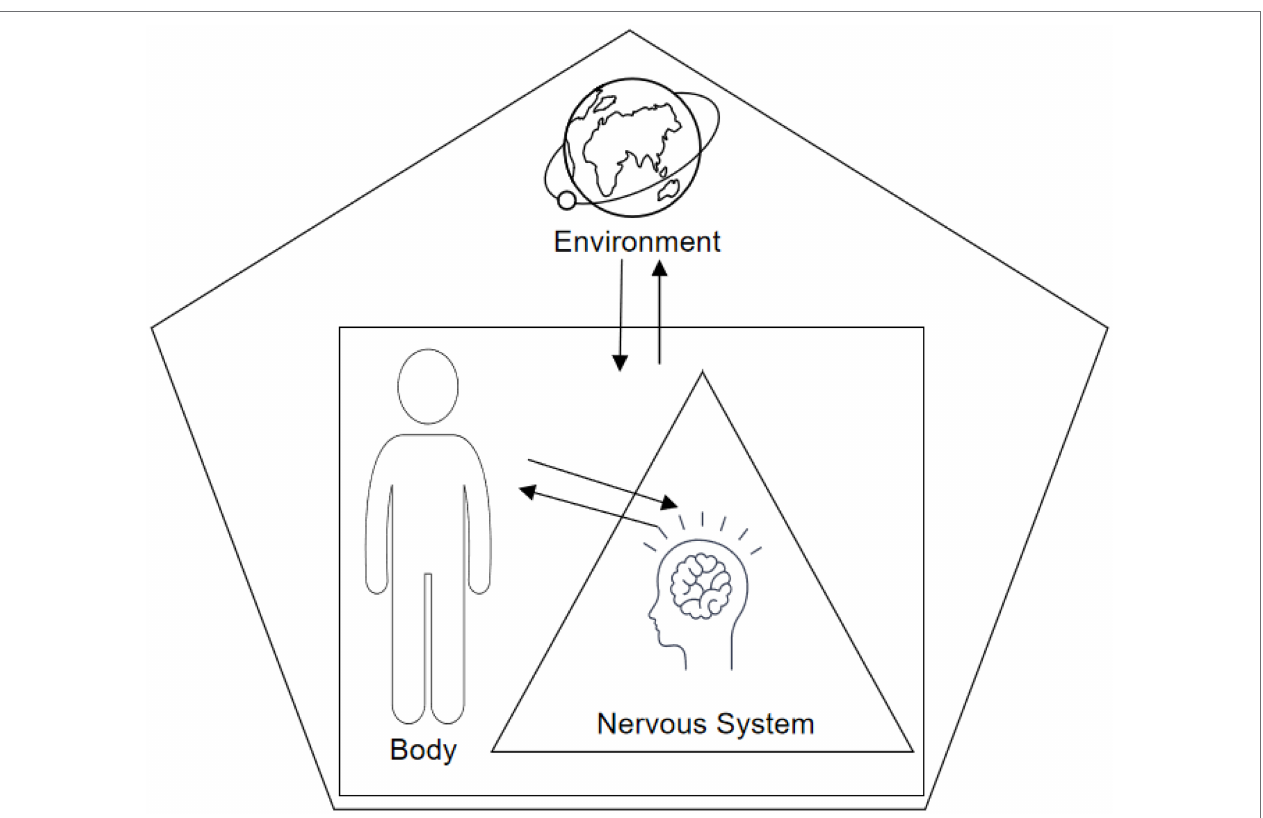
FIGURE 5 | Contextualized body and environment from the perspective of the dynamic system.